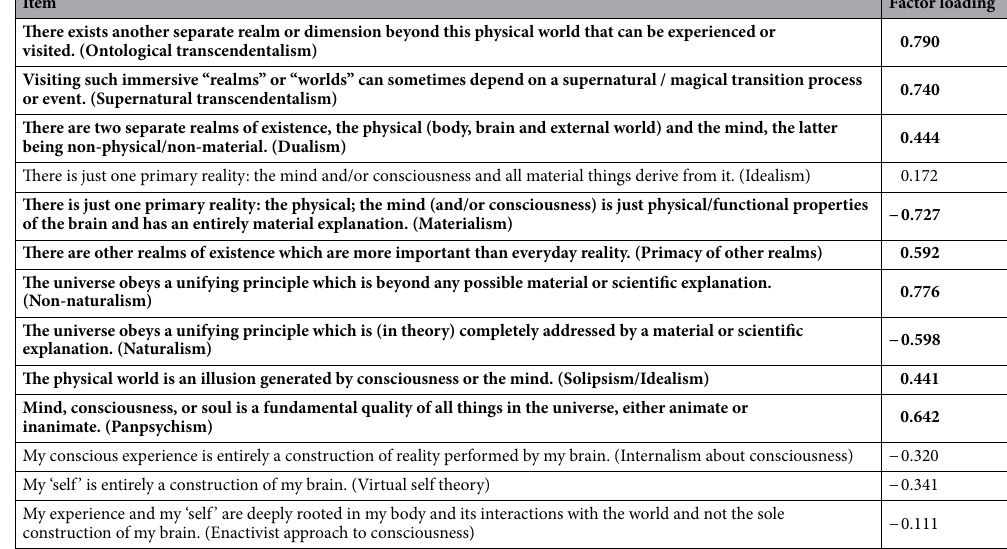
Table 1. Exploratory factor analysis of the Metaphysical Beliefs Questionnaire. The Non-Physicalist Beliefs (NPB) factor is shown in